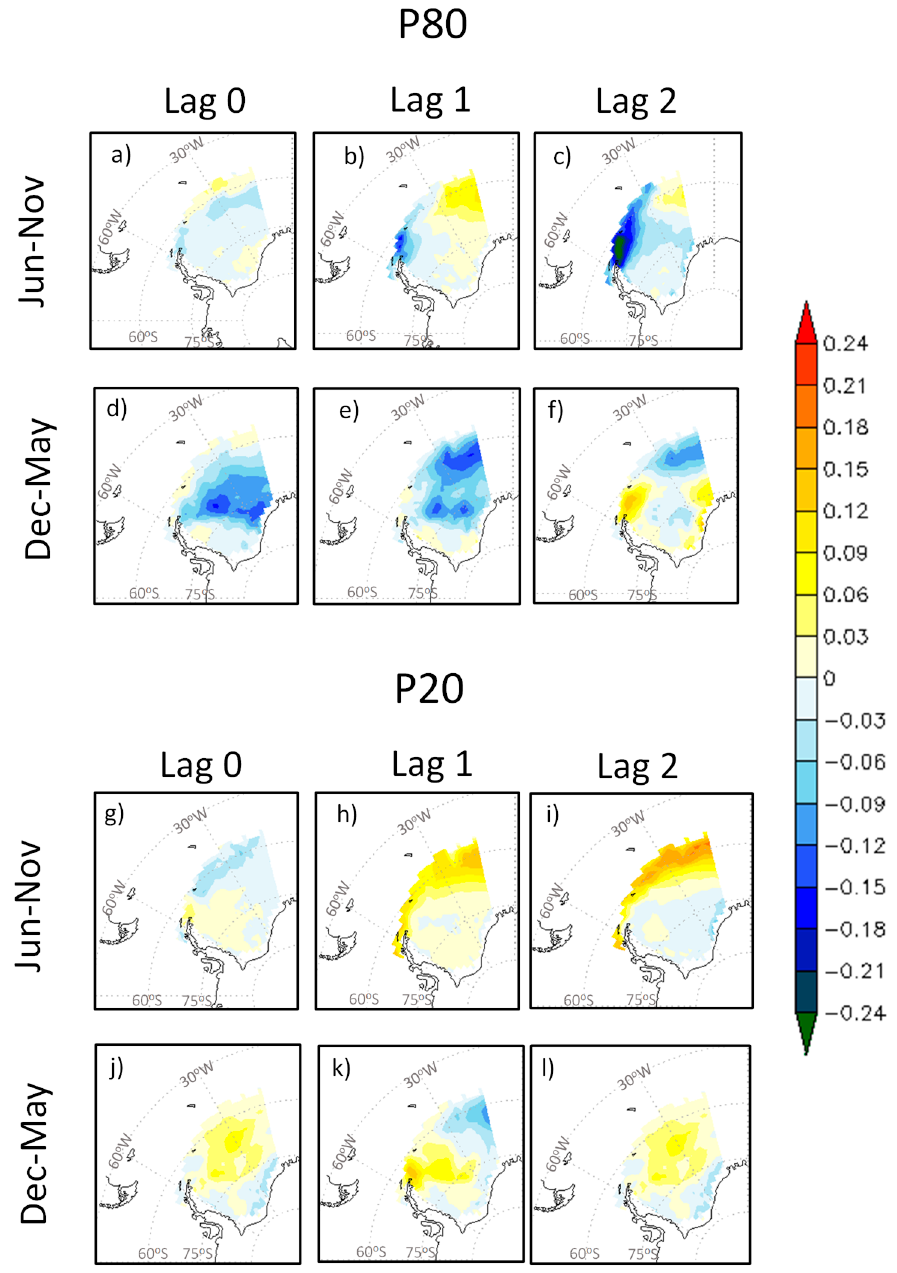
Figure 9. Composite anomalies of SIC for the high (P80, top) and low (P20, bottom) extreme events of the moisture sink for the lags 0 ( a , d , g , j ), 1 ( b , e , h , k ) and 2 ( c , f , i , l ) months. The composites are also separated by periods of maximum (June-November) and minimum (December-May) SIC.